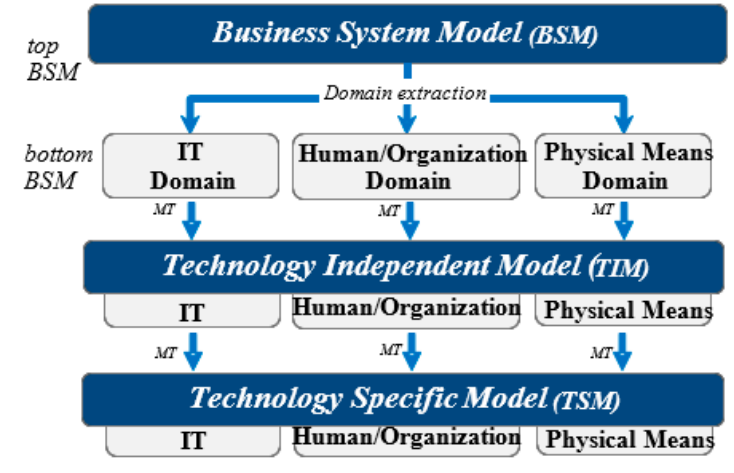
Figure 1. MDSEA methodology.